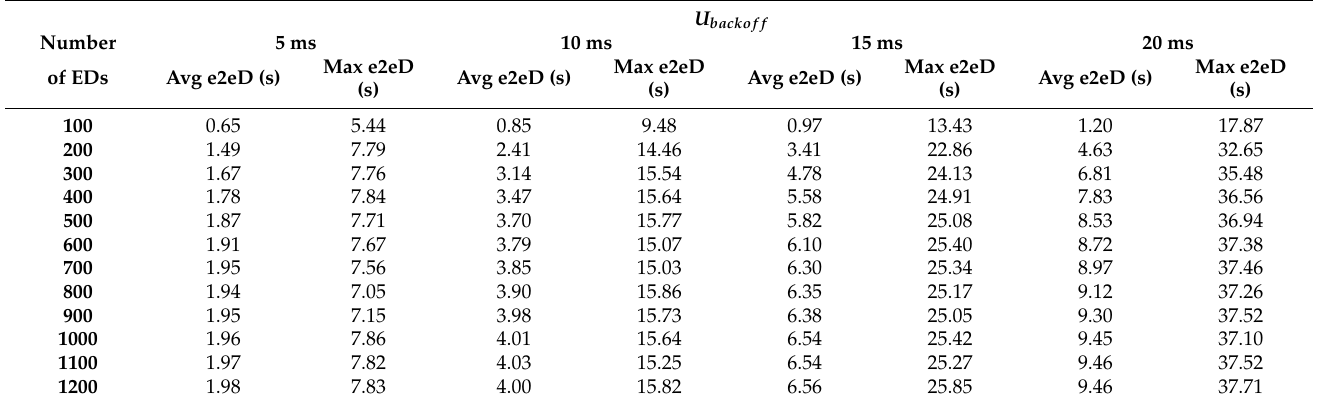
Table 11. Case B ( MAC max = 10): Average and maximum e2eD varying the number of EDs and nBackof f the U backof f